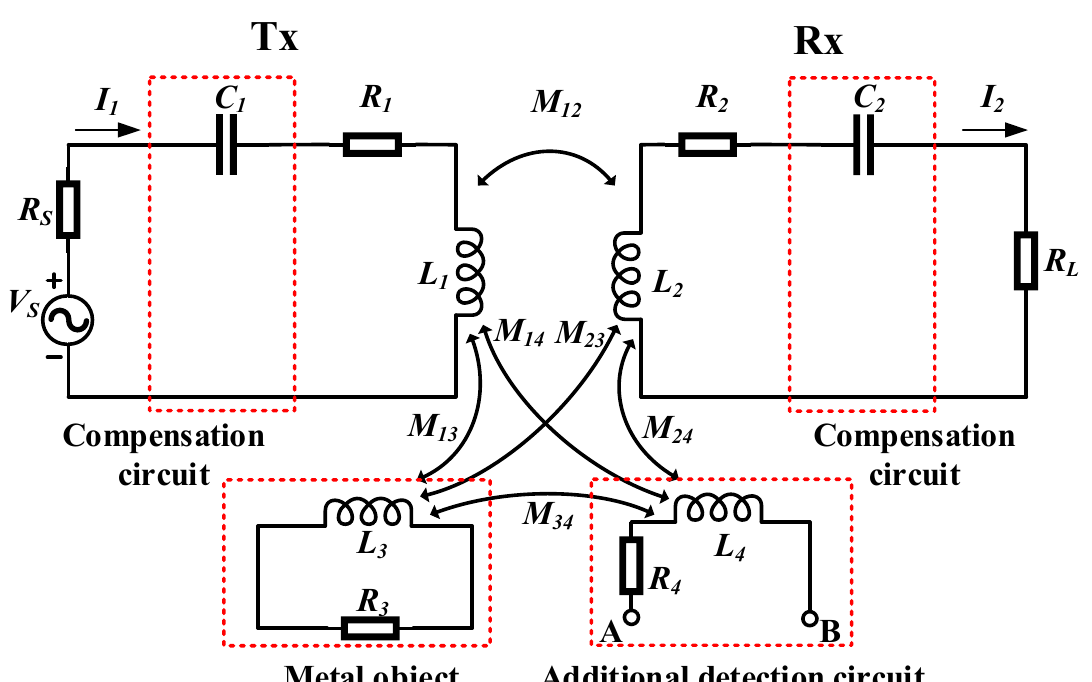
Figure 3. Equivalent circuit model of a metal object in a WPT system.